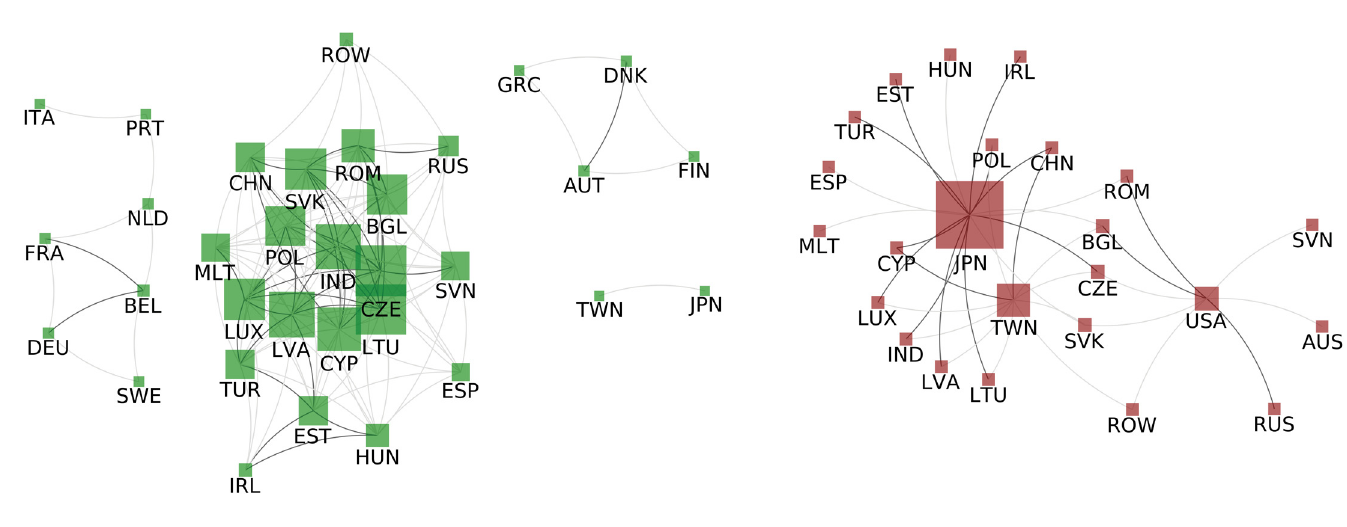
Fig 6. Countries Normalised Strength correlation. Left: Correlated countries- Two countries are connectedwith a dark grey link if the Pearson coefficient betweentheir strengths time series is above T þ countriesare connectedin dark grey if their strengths time series have a Pearson coefficient below T (cid:0) link is light grey. In both the size of of the nodes is proportional to the strength of the node (regardinglight edges).